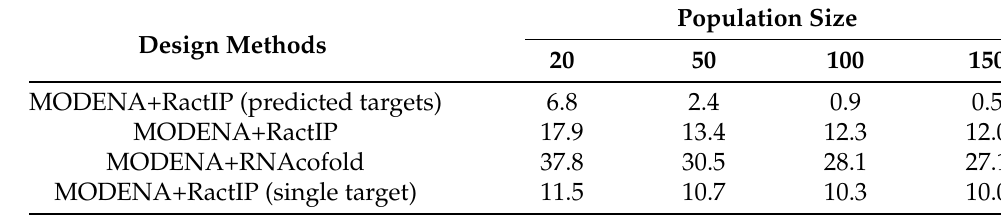
Comparison of the design benchmark results for MODENA+RactIP and MOD- ENA+RNAcofold. The mean structure distance for the dataset is shown, where only the lowest structure distance in each of the RNA species is taken into account. The “predicted dataset” indicates the designs with the target structures predicted by RactIP. The “single target” indicates the results for single-target joint structure designs, where the natural dataset was used. A smaller value indicates a better